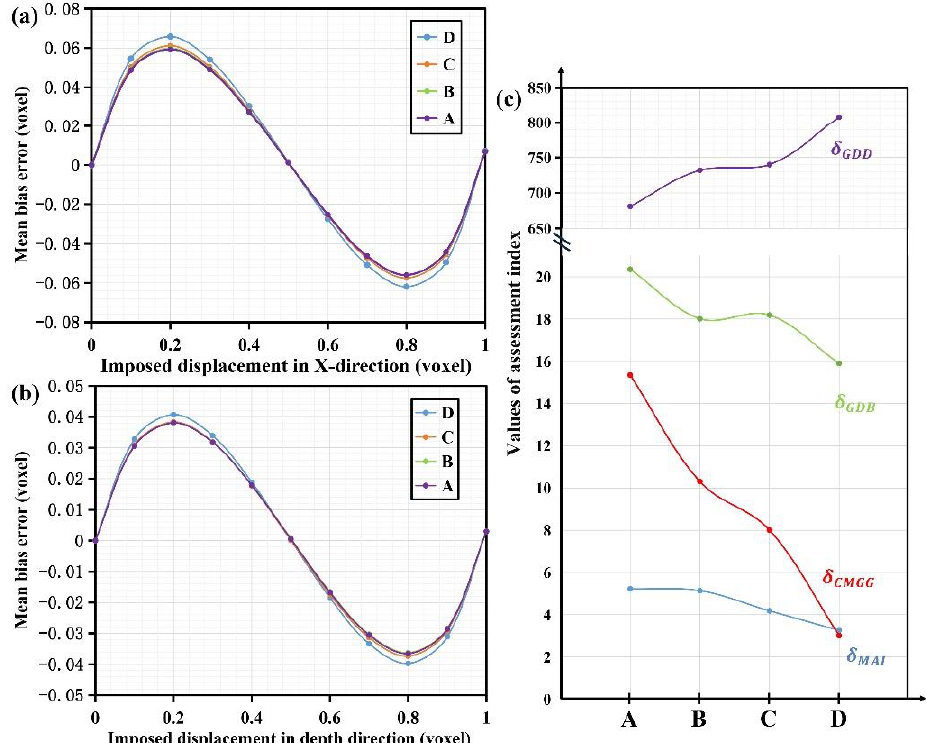
Figure 8. The influence of different reference arm laser intensities based on CMGG. ( a ) Mean bias errors of imposed displacement in X direction. ( b ) Mean bias errors of imposed displacement in depth direction. ( c ) Evaluation index of OCT image under different reference arm laser intensities.